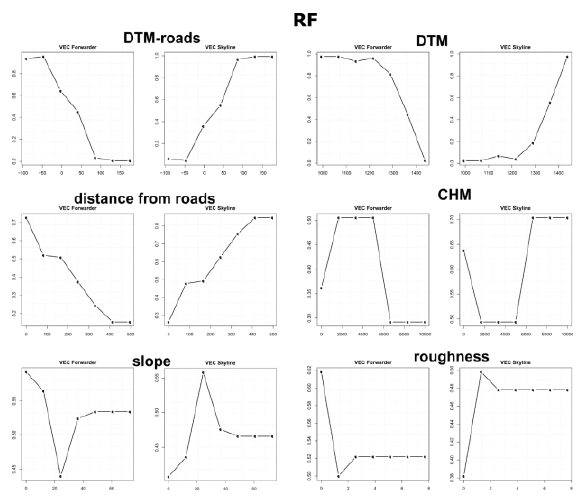
Figure 5. Random Forest relative importance of the input variables. The x-axis reports the AAD metric.